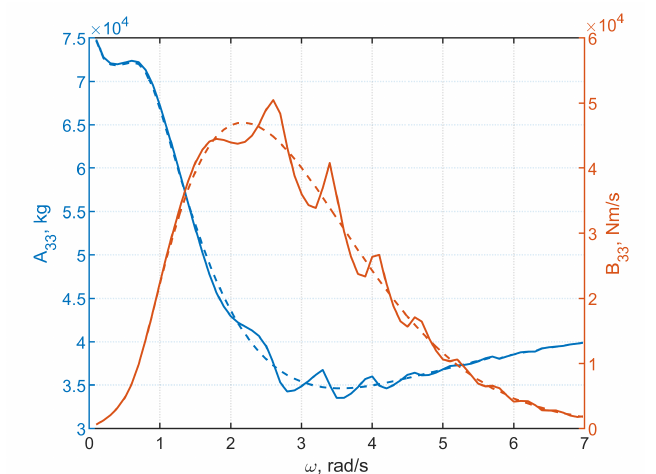
Figure 5. The added mass A 33 and the radiation damping B 33 of the buoy with a radius of 4 m for two WEC concepts: slack concept (dashed line) and stiff concept (solid